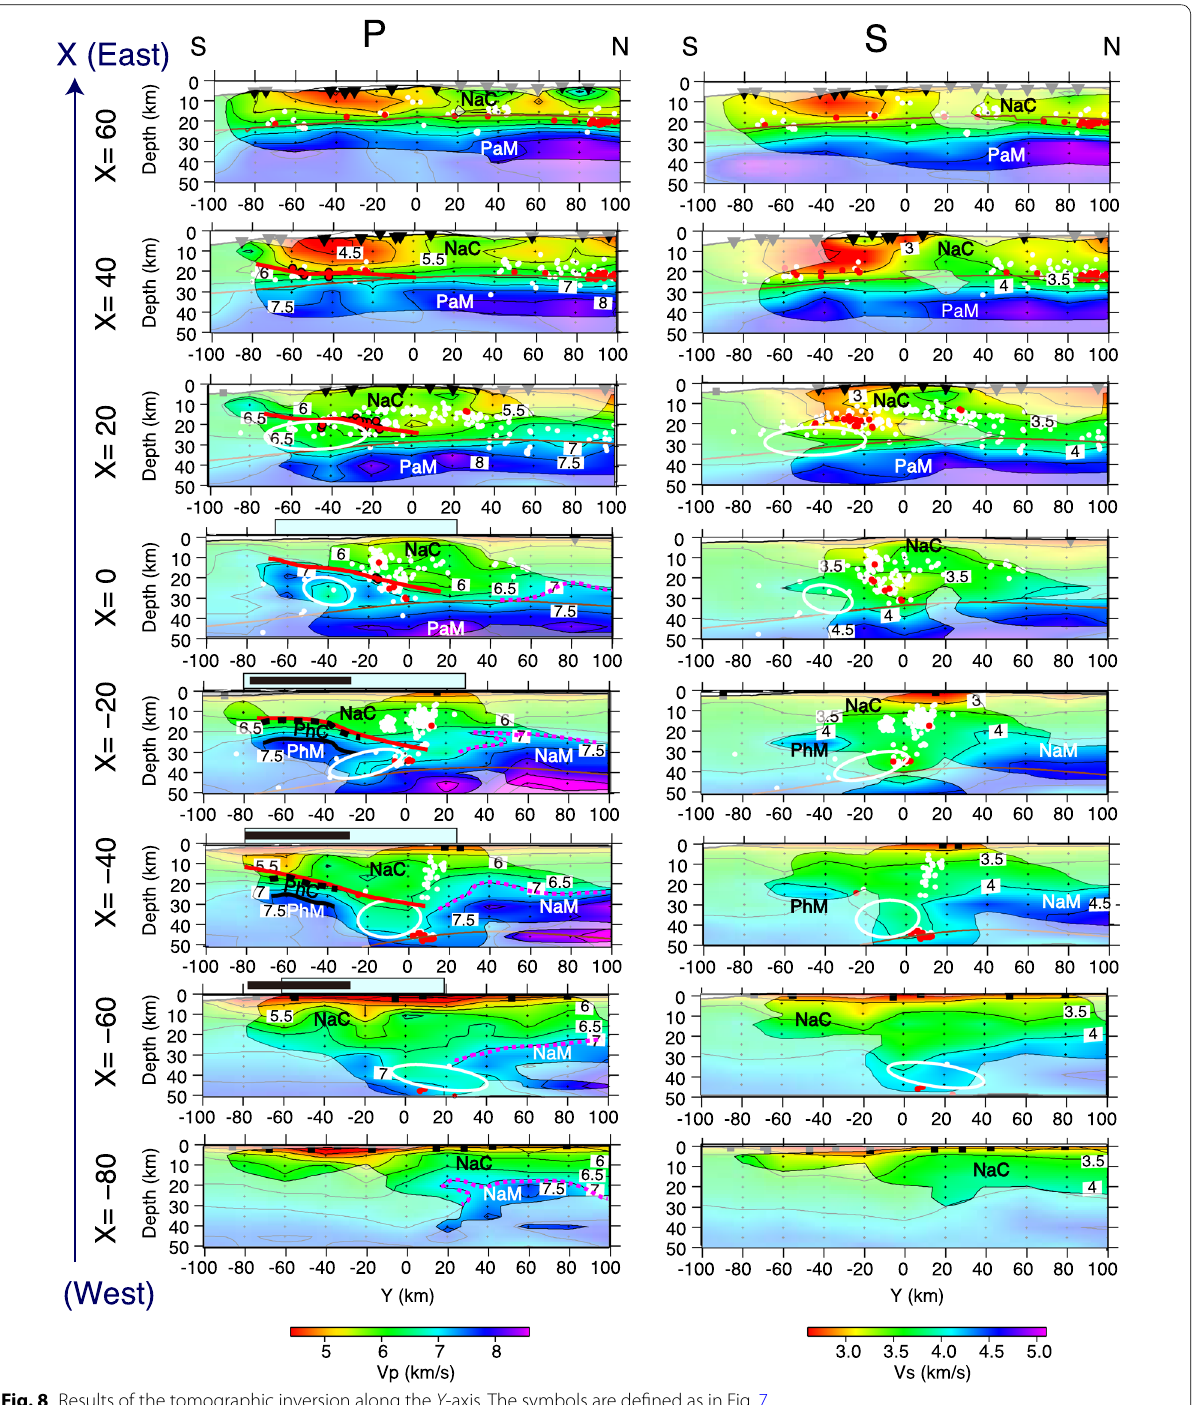
Fig. 8 Results of the tomographic inversion along the Y -axis. The symbols are defined as in Fig.